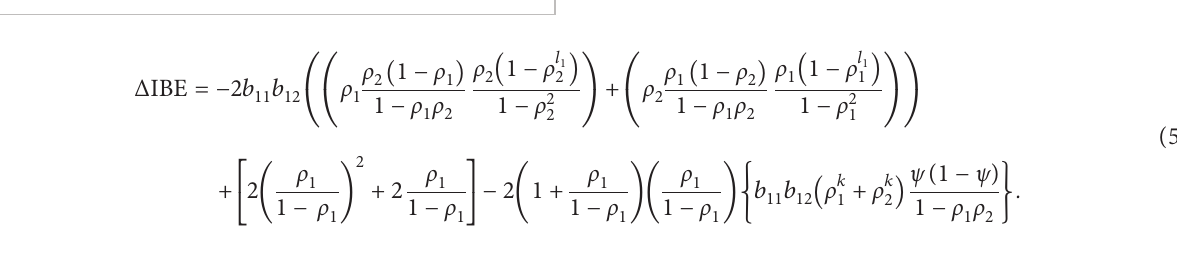
Figure 9: The impact of ρ